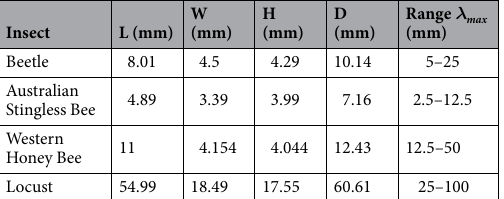
Table 1. Dimensions of the studied insect models along the different axes shown in Fig. 1. L, W, and H, are the dimensions in the X, Y, and Z, directions, respectively. D is the size of the diagonal of the brick with dimensions L × W × H. The final column lists the range in wavelengths where the maximal P abs ( λ max ) will be